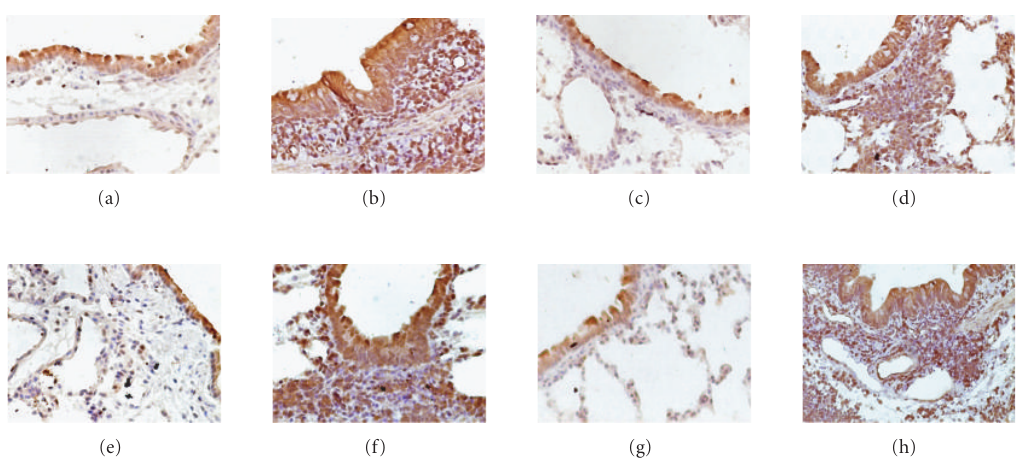
Figure 1: Expression of NK-1R, LIF, p-STAT3, and p-ERK1/2 in lung tissues of asthmatic rats (SABC × 200 ) . Immunohistochemistry was performed on lung tissue of asthmatic rats. There were higher expressions for NK-1R ((a) control group, (b) asthmatic group) and LIF ((c) control group, (d) asthmatic group) in the asthmatic rats than those in the control rats, and the similar changes were observed for p-STAT3 ((e) control group, (f) asthmatic group) and p-ERK1/2 ((g) control group, (h) asthmatic group). The main positive cell type was airway epithelial